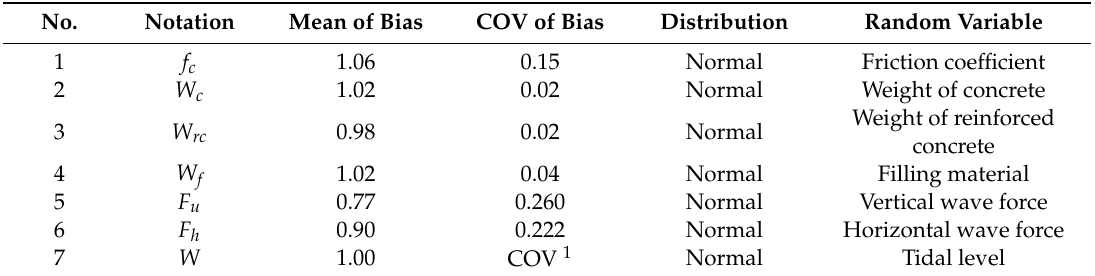
Table 2. Statistical properties of the uncertainties applied in the overall stability analysis.